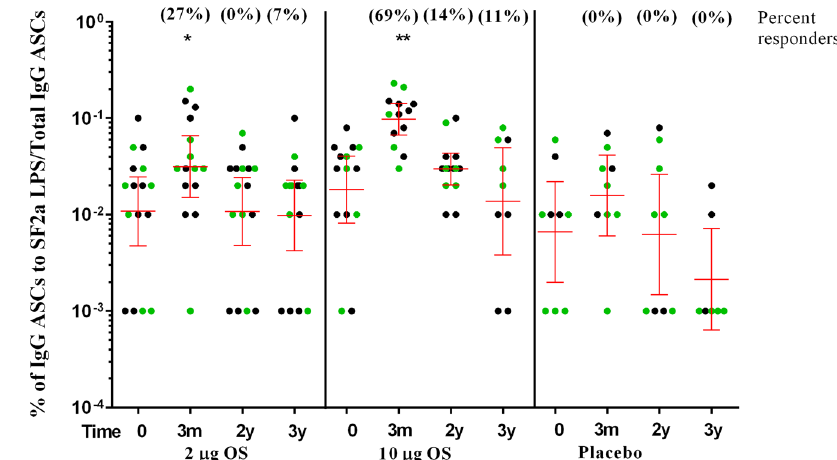
Fig. 4 Longevity of IgG memory B-cells to SF2a LPS in vaccinees receiving 2 or 10 µg OS doses of non-adjuvanted and adjuvanted SF2a- TT15 and in placebo recipients. Circles represent individual percent of IgG antibody secreting cells (ASCs) to SF2a LPS /Total IgG ASCs, green circles represent volunteers receiving the adjuvanted vaccine or placebo. Bars represent the Geometric Mean (GM) and 95% Con fi dence intervals (CIs) of these values on day 0 (baseline), at 3 months, 2 and 3 years post-vaccination. * p -value < 0.05; ** p -value < 0.01 (vs. day